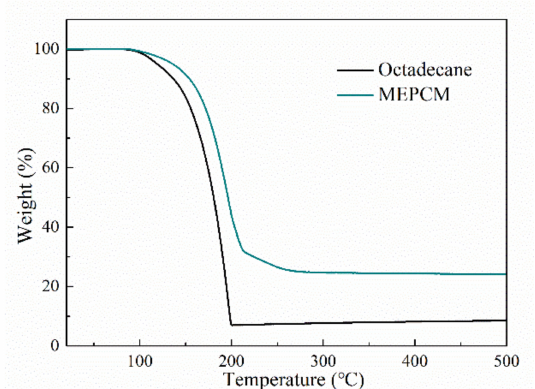
Figure 5. TGA curves of n-octadecane and